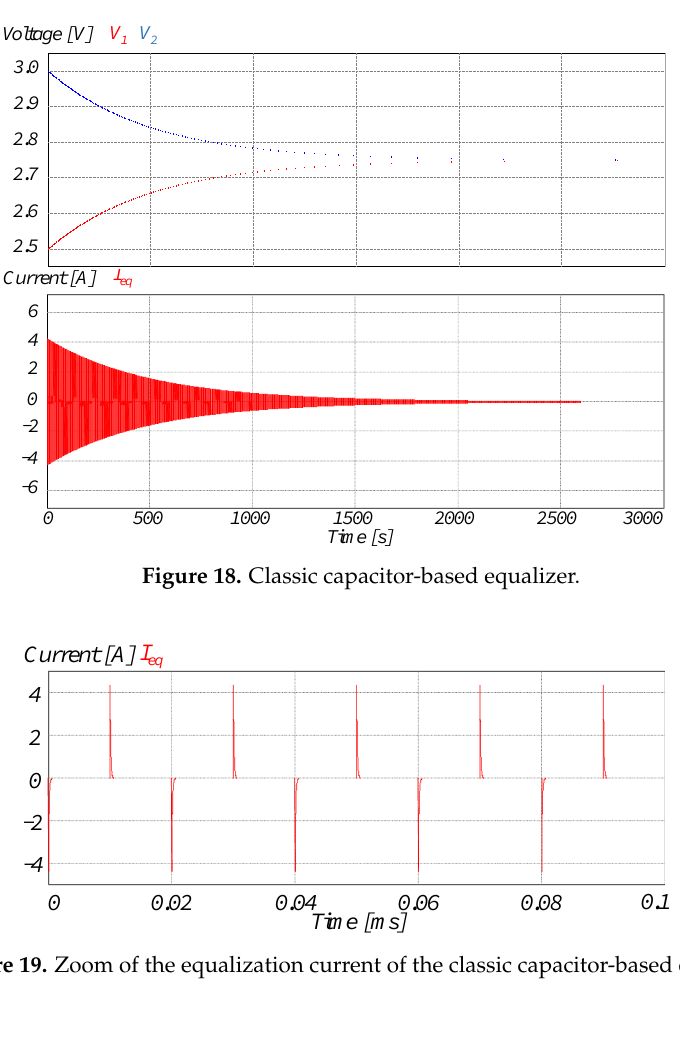
Figure 17. Classic resistor-based equalizer with constant-current charge method ( I ch = 1.25 A).